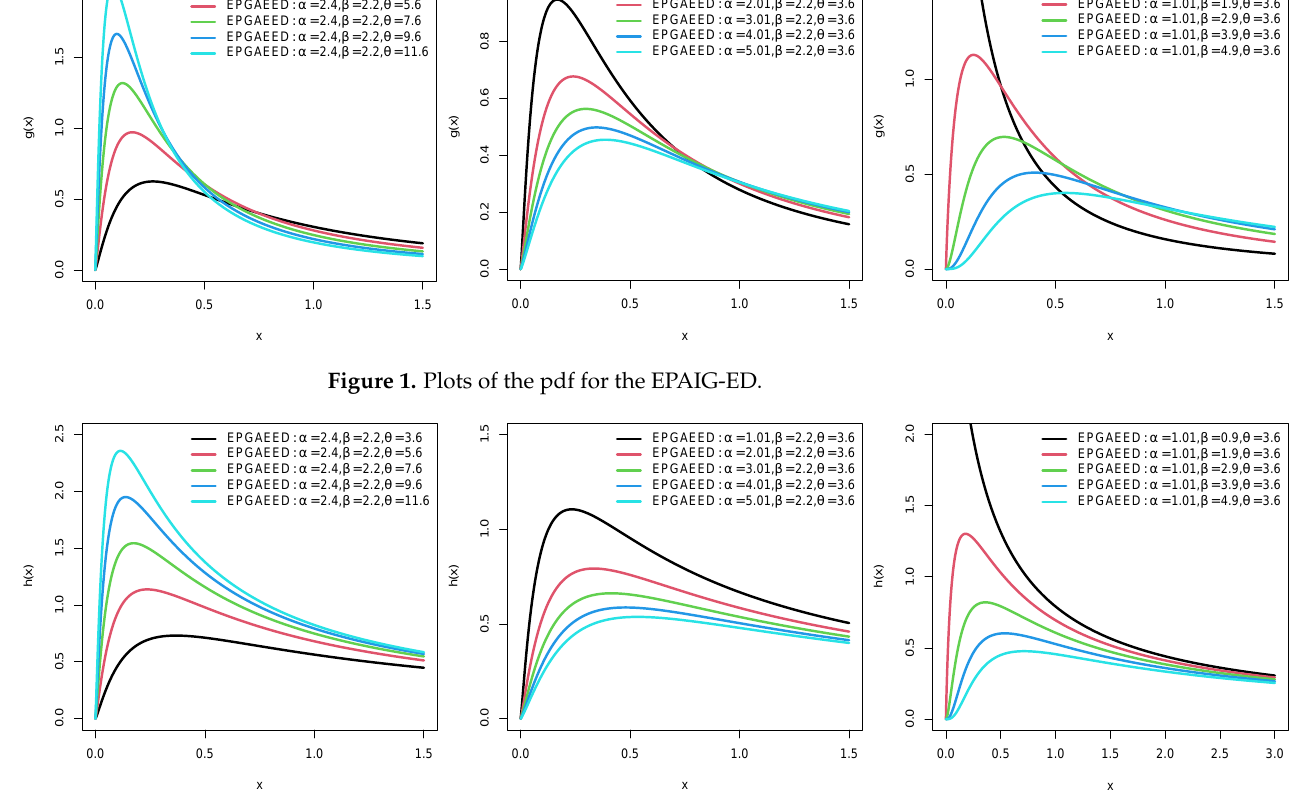
Figure 2. Plots of HRF for the